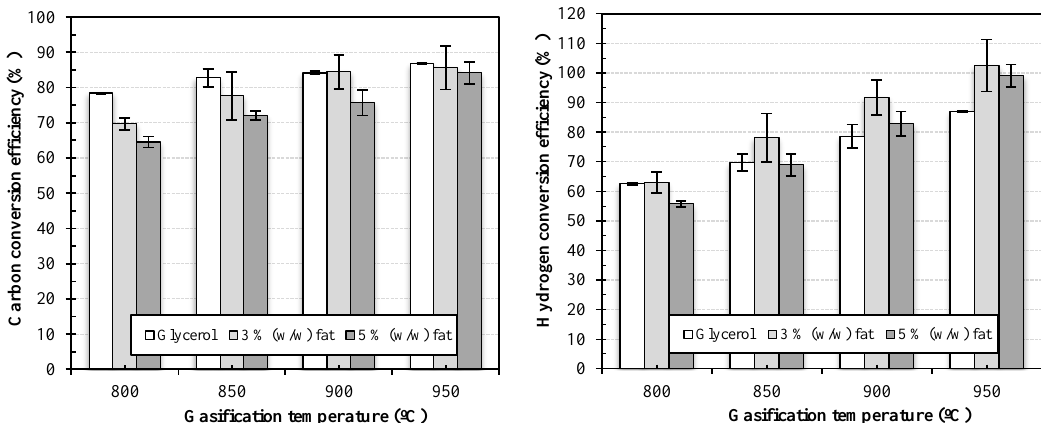
Figure 7. Effect of gasification temperature and fat content in the producer gas composition.